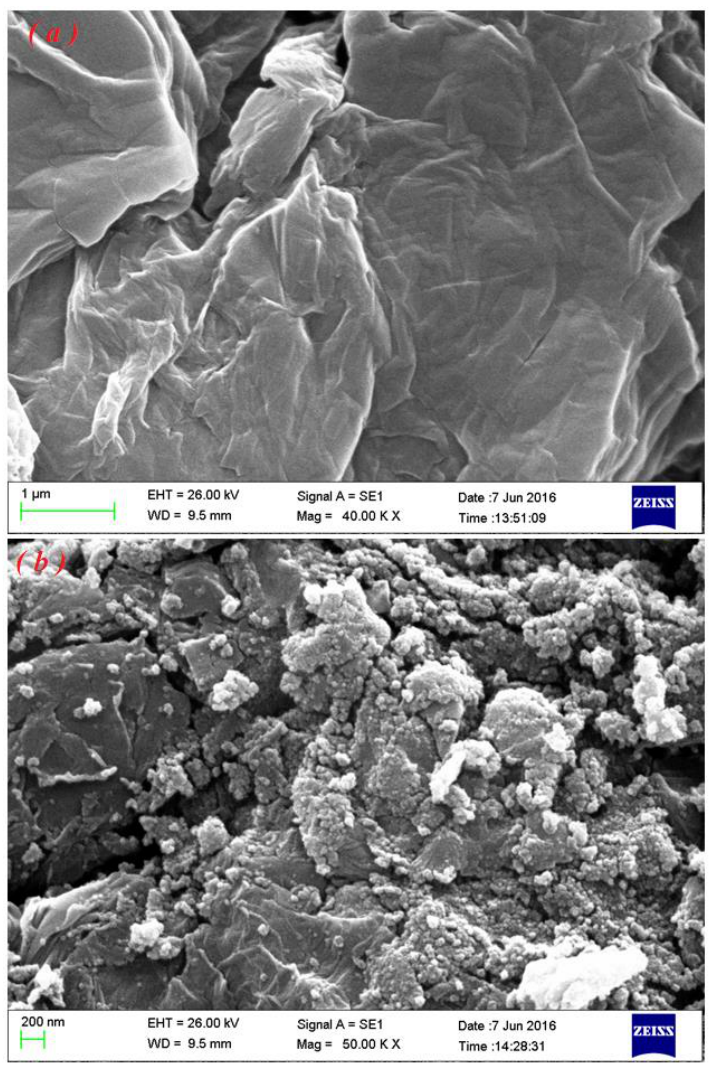
Fig. 4 SEM images of graphene (a) before and (b) after immobilization of